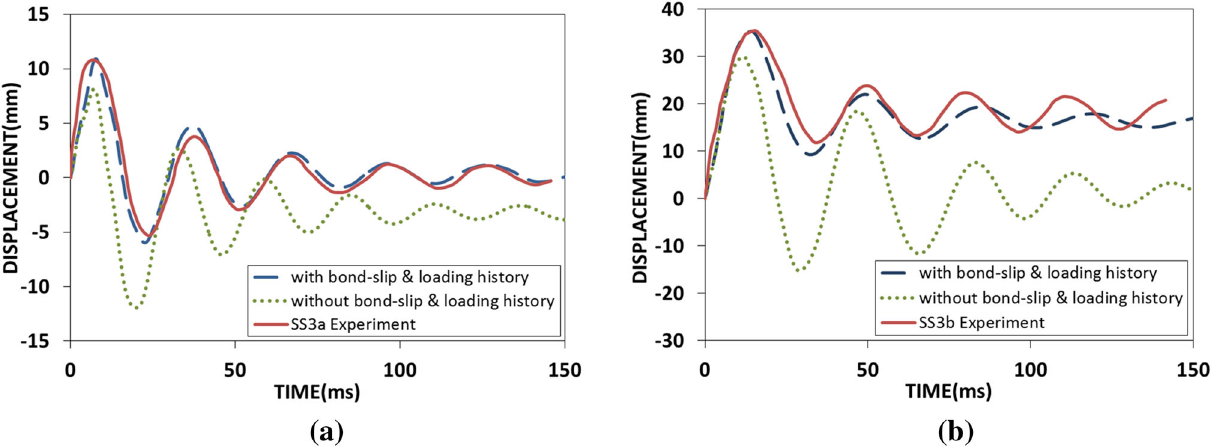
Fig. 13 Comparison of mid-span deflection with time for beams a SS3a and b SS3b.